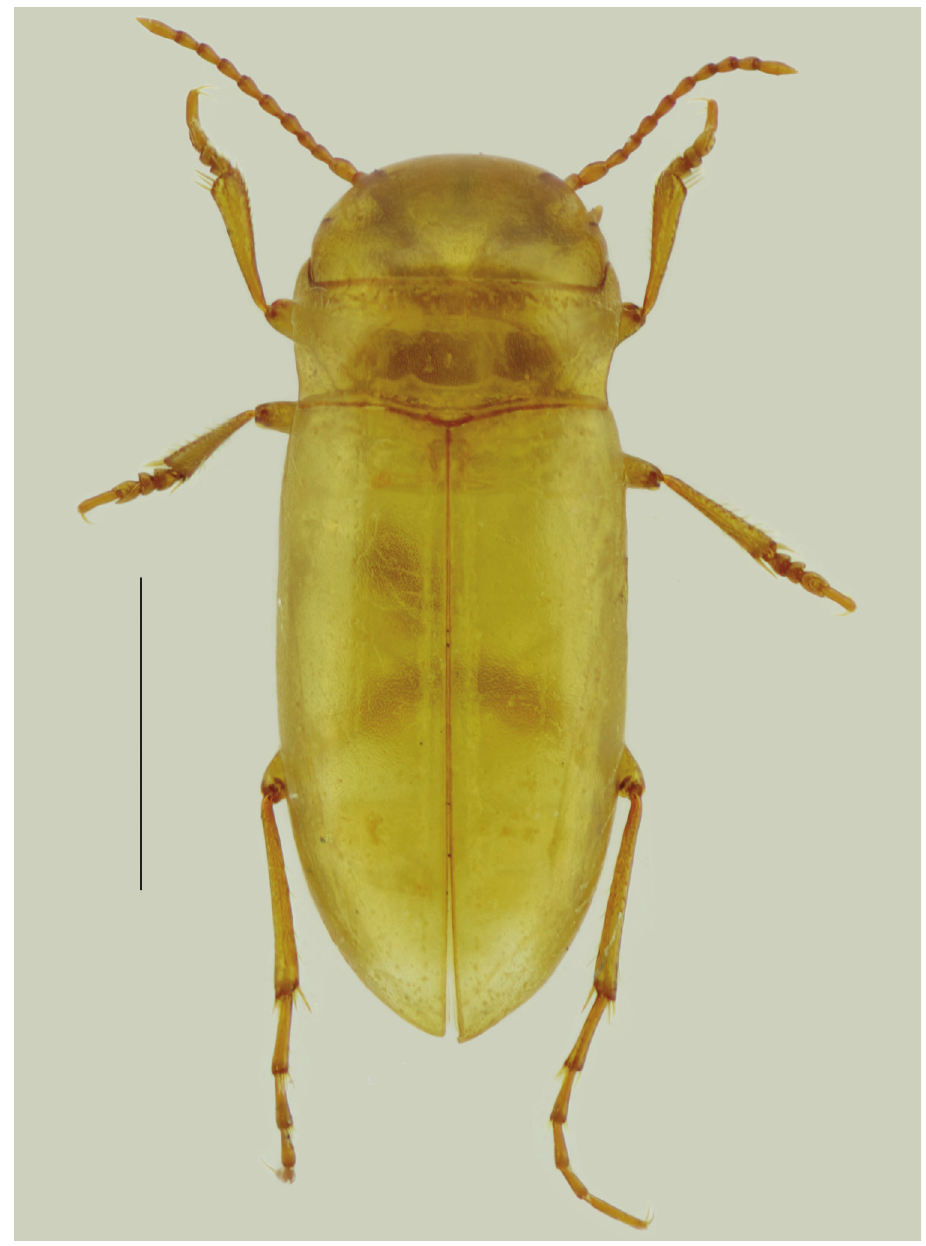
Figure 2. Habitus of Iberoporus pluto sp. n., dorsal view (holotype, after DNA extraction). Scale bar: 1 mm. cal System, located in the north-eastern part of the Sicó karst area in central Portugal (Neves et al. 2005). The subterranean stream feeds the spring of the Dueça River, a contributor to the Mondego River. The substrate of the river is mostly composed